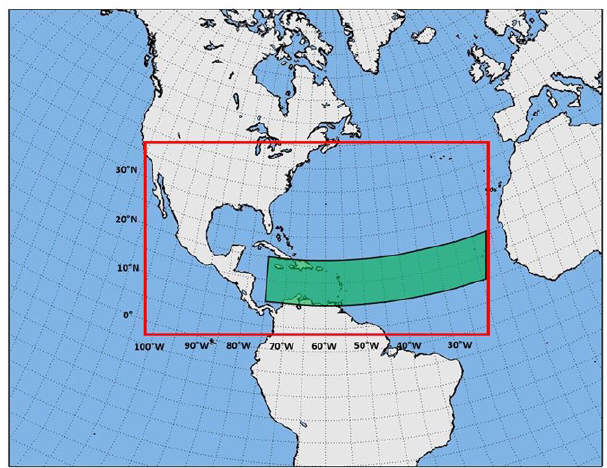
Figure 1. CRCM6 simulation domain (red box). The black/green shaded box shows the approximate present-day tropical cyclone main development region (MDR). Note that the data are projected over an equidistant cylindrical